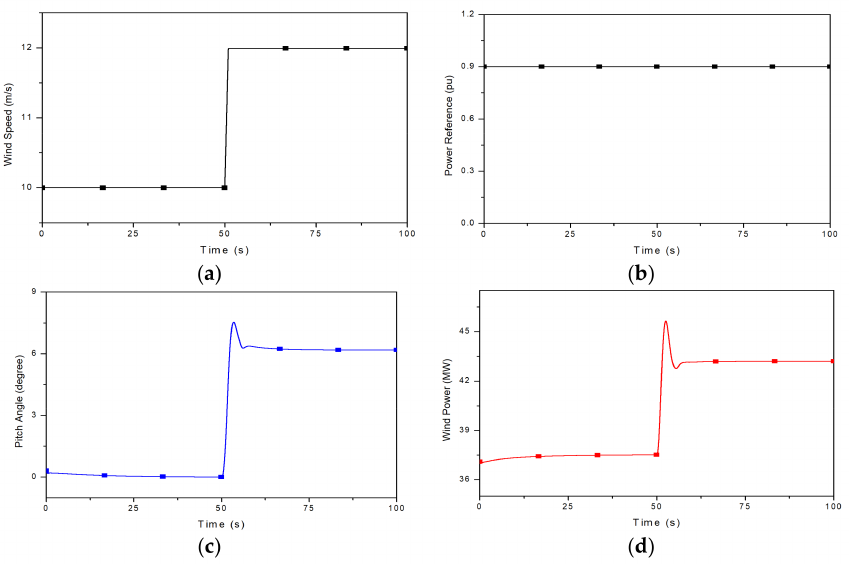
Figure 19. Simulation results with power reference: ( a ) Wind speed; ( b ) Power reference; ( c ) Pitch angle; ( d ) Wind